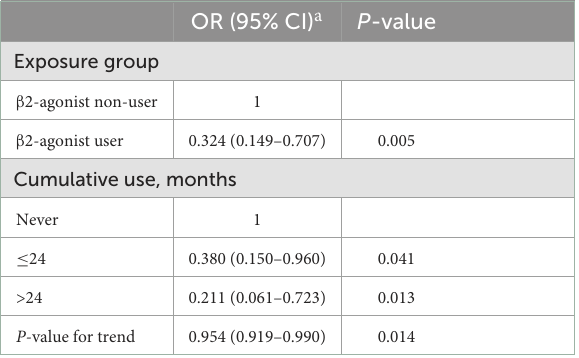
TABLE 2 Association between β 2-agonist users and risk of